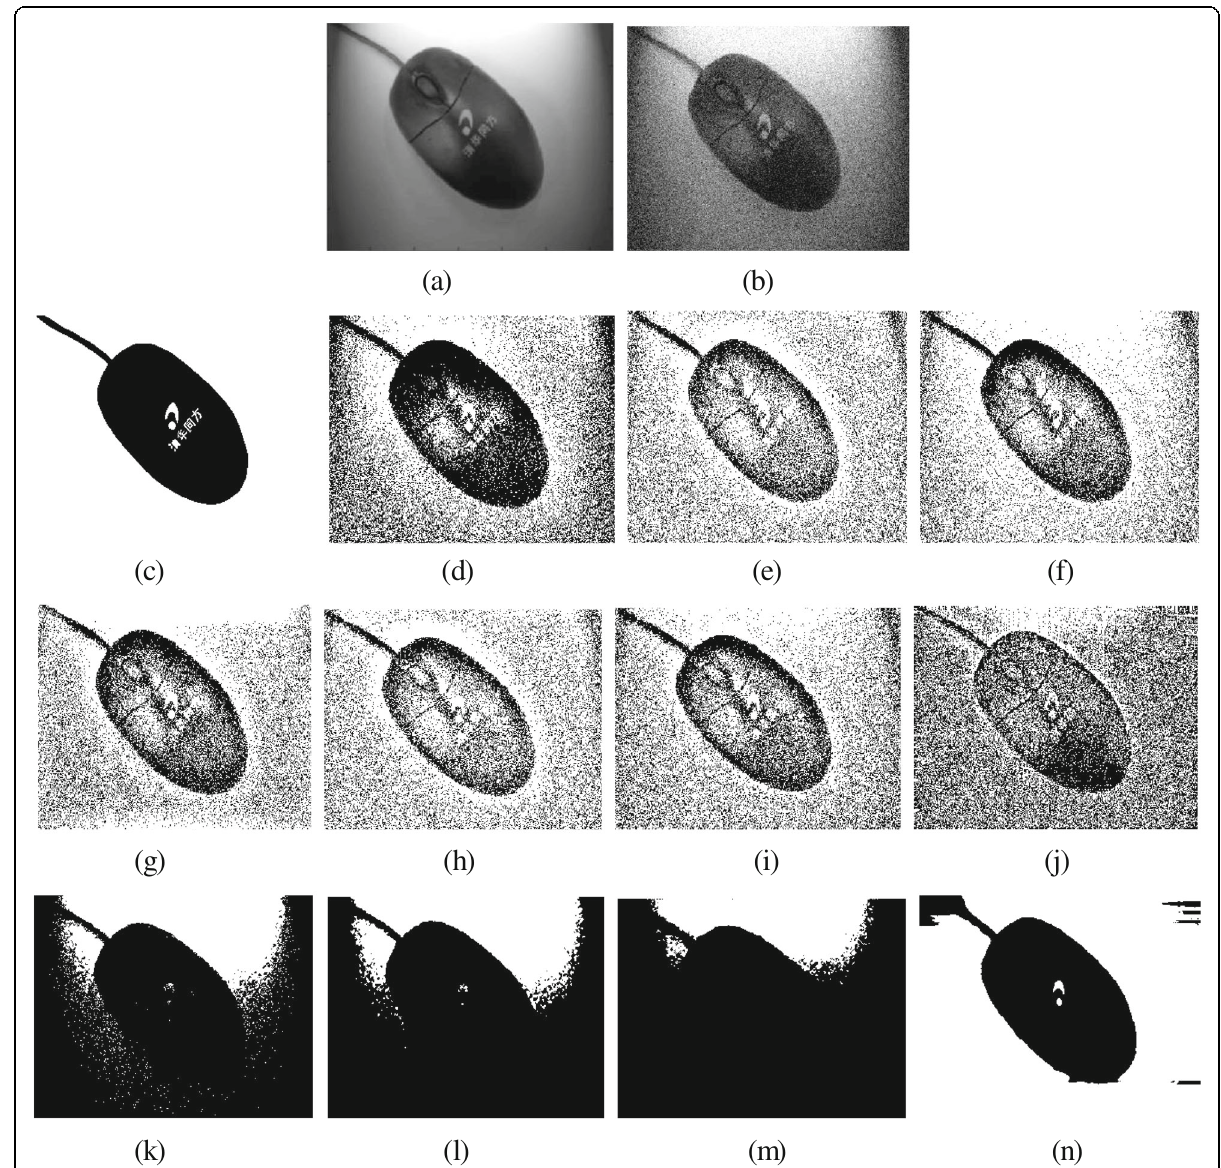
Fig. 9 Segmentation results on the mouse image 243 × 326 corrupted by the Gaussian noise (0, 0.010). a Original image. b Noisy image. c Ground-truth. d Bernsen ’ s method. e Niblack ’ s method. f Sauvola ’ s method. g Bradley ’ s method. h Chou ’ s method. i Valizadeh ’ s method. j Wei ’